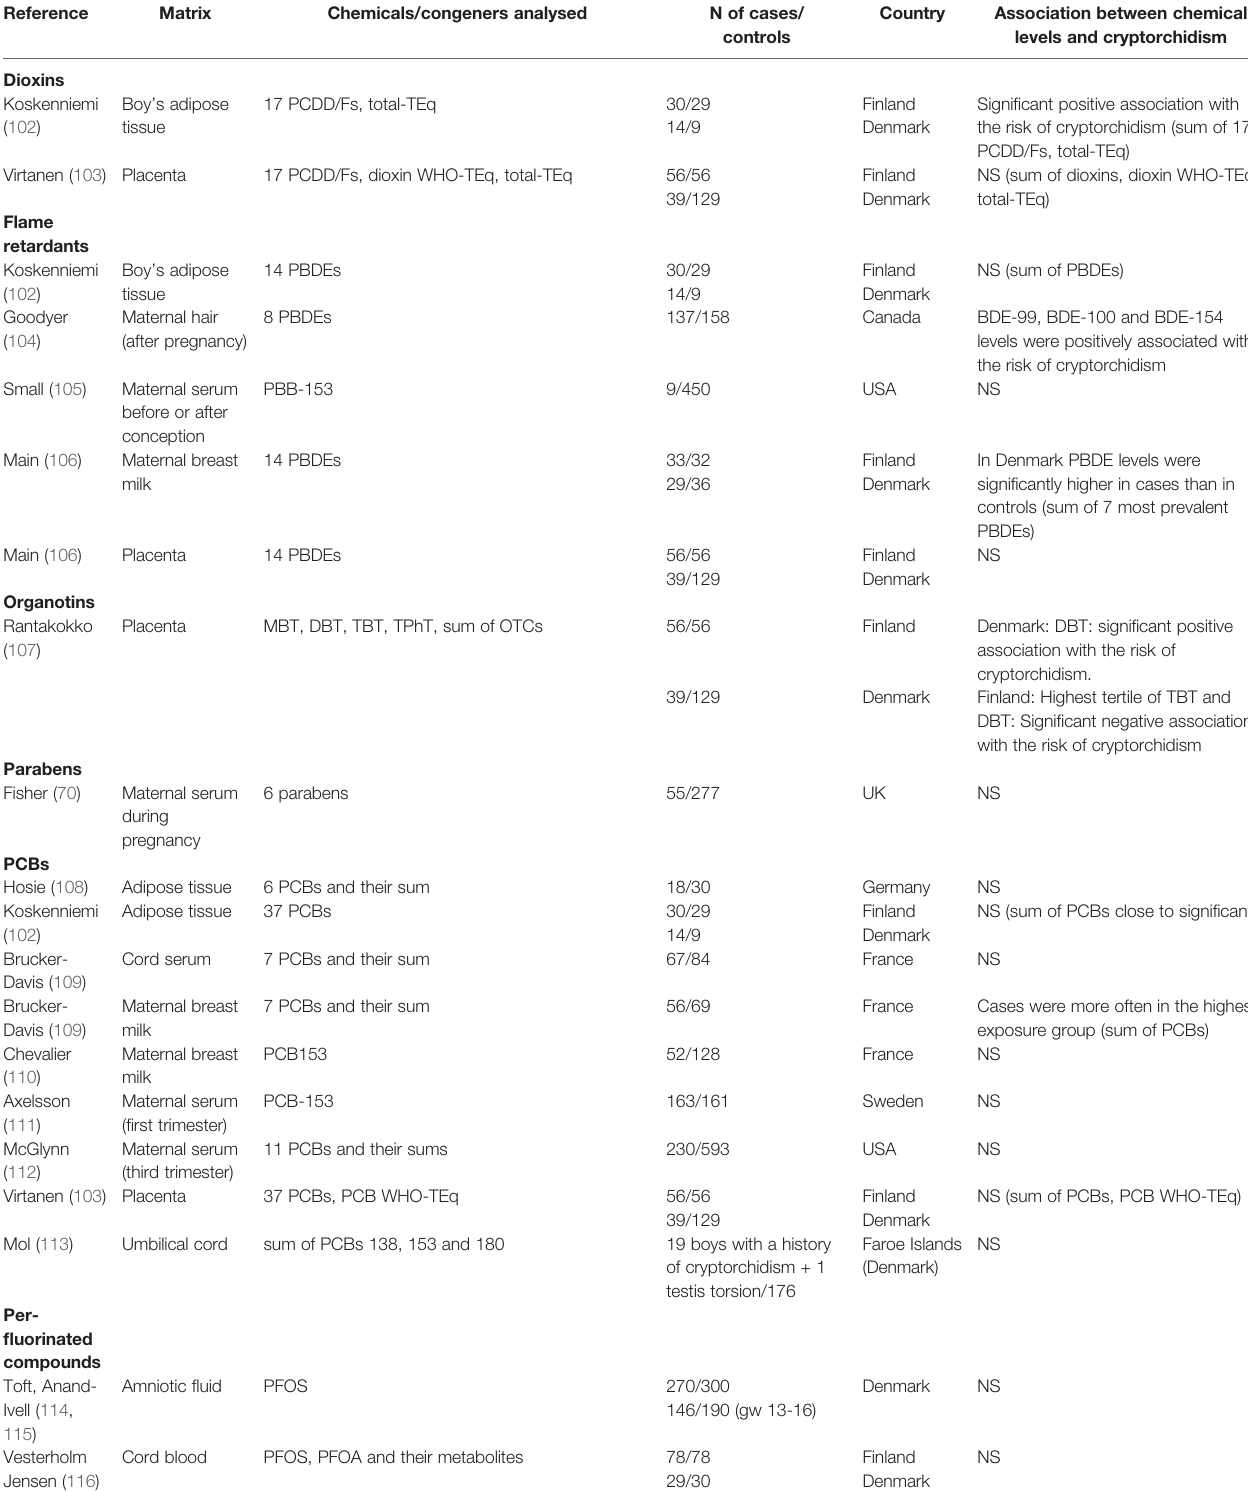
TABLE 2 | Case-control studies on the association between exposure to different classes of environmental EDCs (based on matrix measurements) and cryptorchidism in boys.